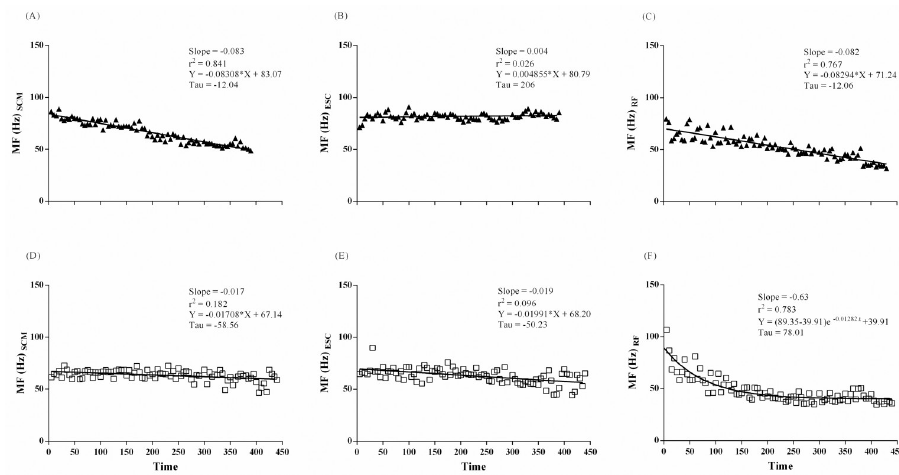
Fig 4. sEMG frequency median of SCM (A and D), ESC (B and E), and RF (C and F) muscles on ISWT, in COPD- group (close triangles) on upper panel and control group (open square) on the lower